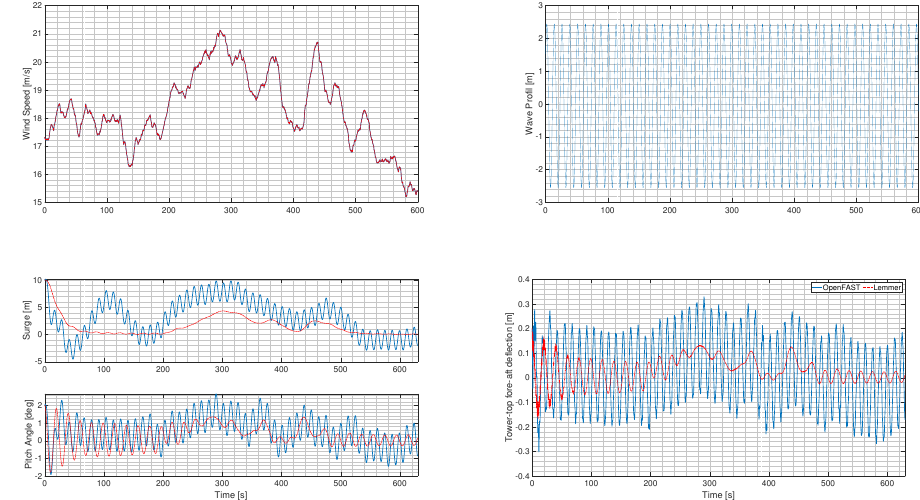
Figure 6. Simulation comparison in region 3 with OpenFAST code in blue and Lemmer model in red: wind speed profile ( top-left ), wave profile ( top-right ); surge and pitch translational DOFs ( bottom-left ) and tower-top fore-aft deflection ( bottom-right